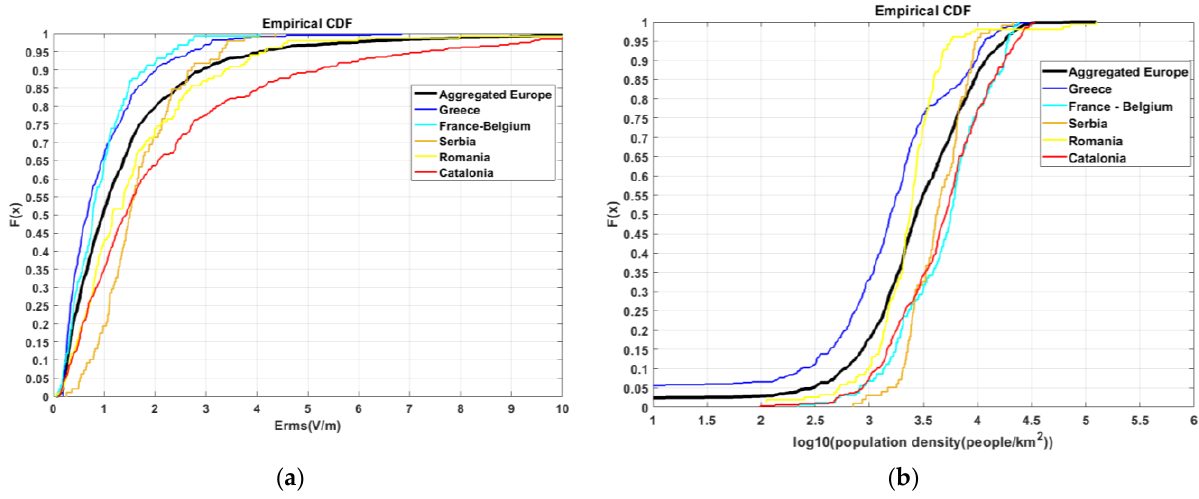
Figure 4. Cumulative density functions (CDFs) for ( a ) distribution of measuring sensors’ E rms values and ( b ) distribution of measuring sensors’ surrounding area population density.